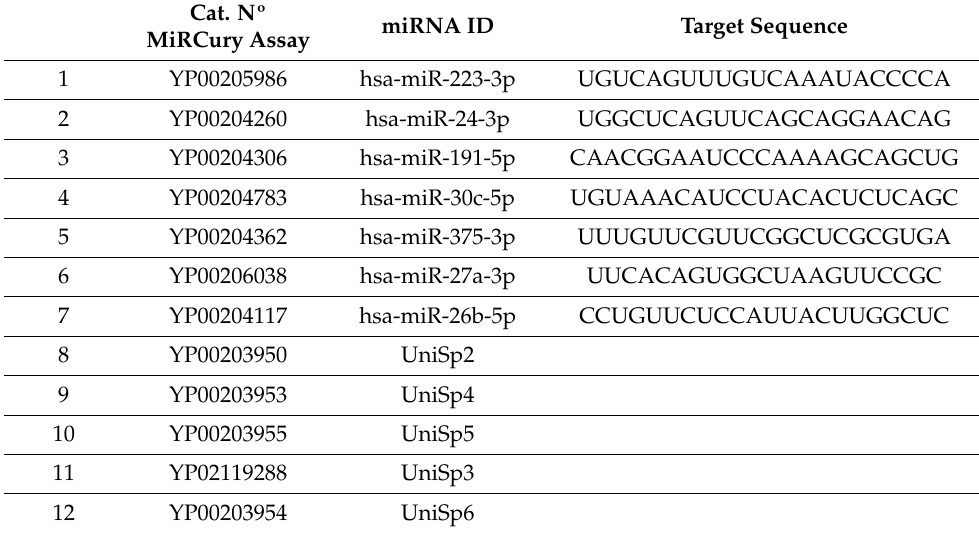
Table 5. Hsa-miRNA sequences and synthetic spike-in controls analyzed in this